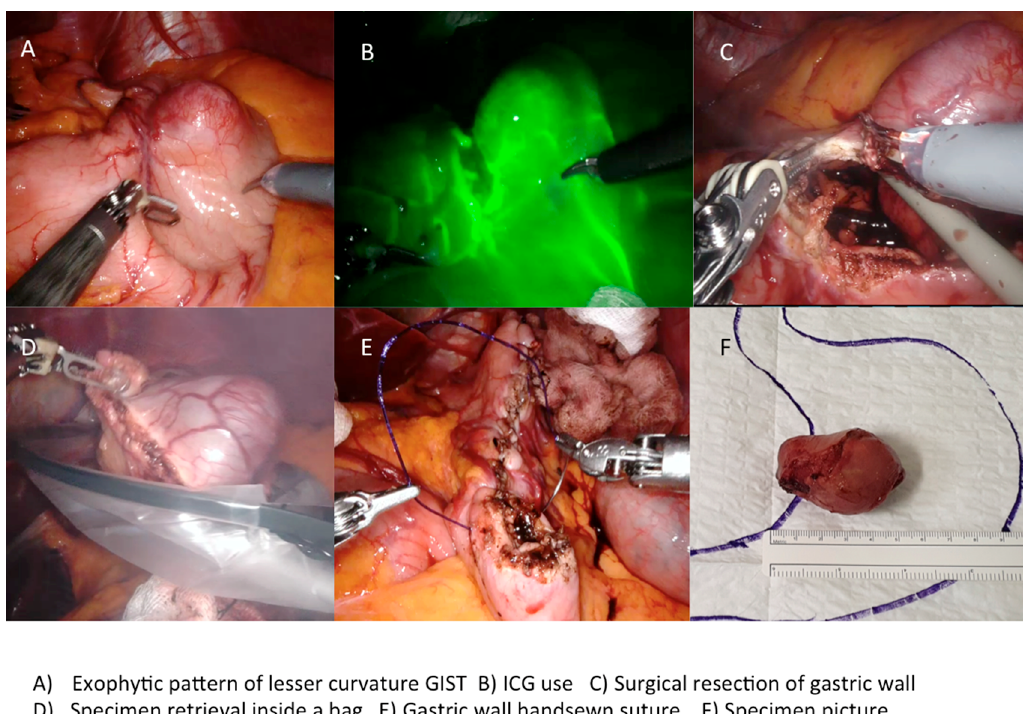
Figure 4. Use of Indocyanine green (ICG) technique during surgical procedures and GIST resection.